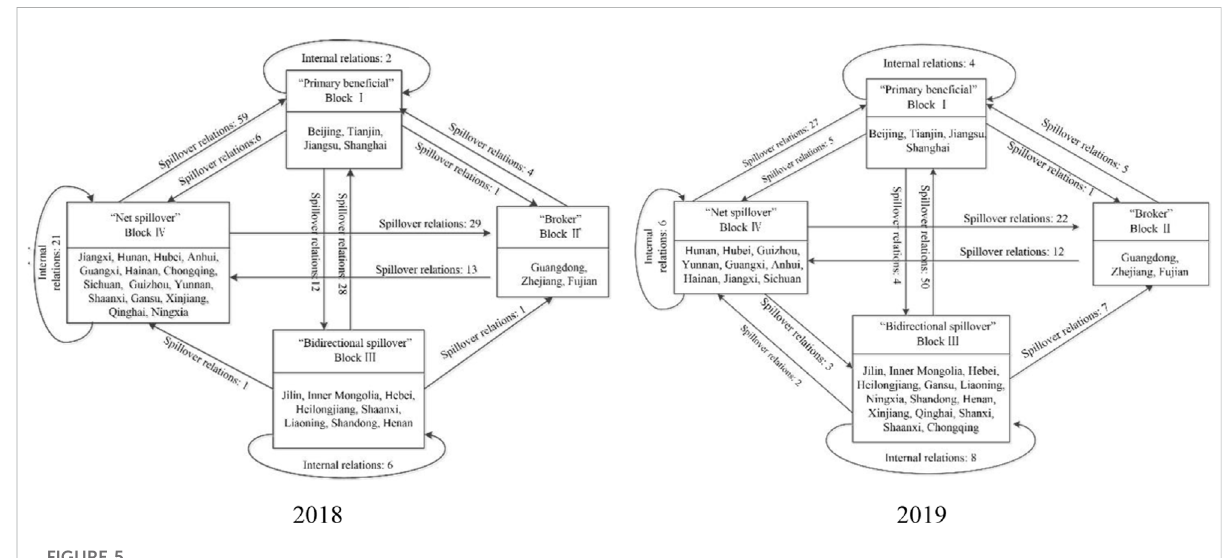
FIGURE 5 The relations between the four blocks of China ’ s regional GIE.